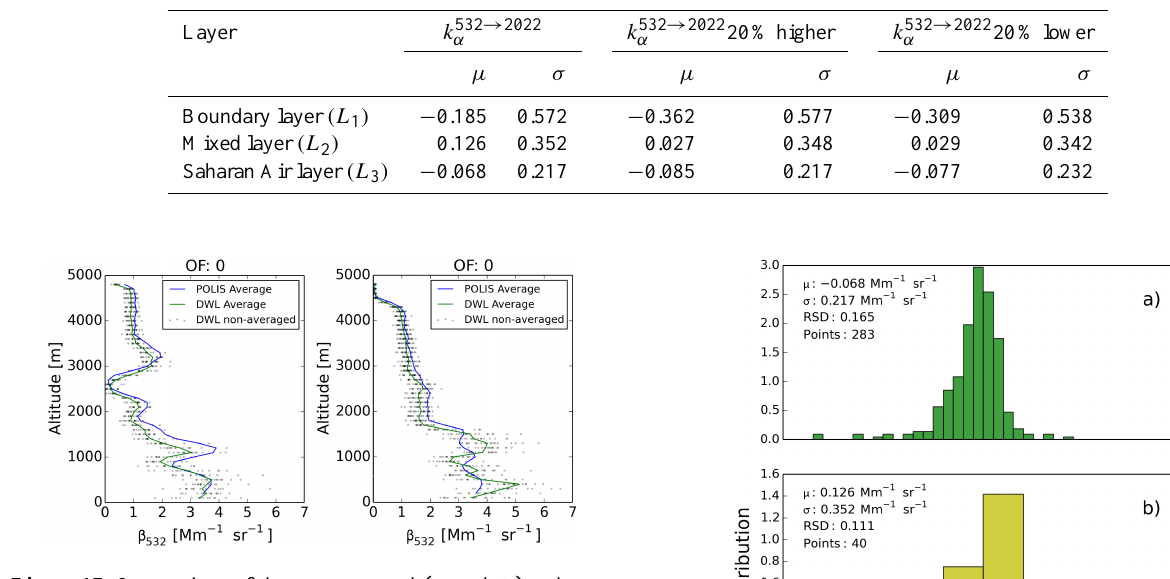
Figure 17. Comparison of the non-averaged (grey dots) and aver- aged (green) backscatter coefficient profiles corresponding to the retrieved data for the flights on 10 July (left) and 11 July (right), and the averaged profiles measured by POLIS (blue) during the Fal- con overflights (OF).